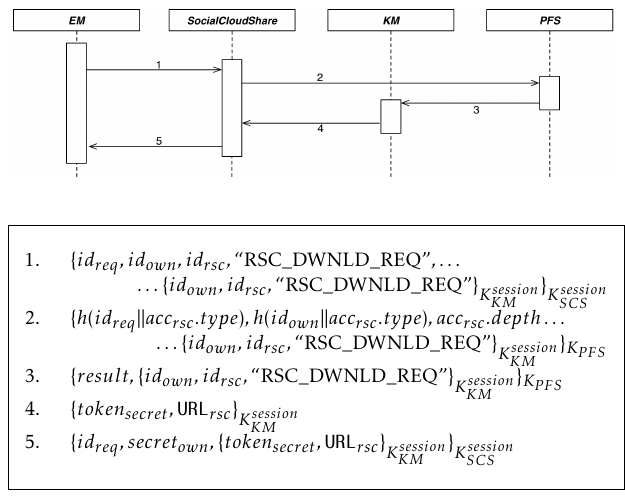
Figure 11. Resource download phase: messages exchange The URL sent from the KM (see message 4